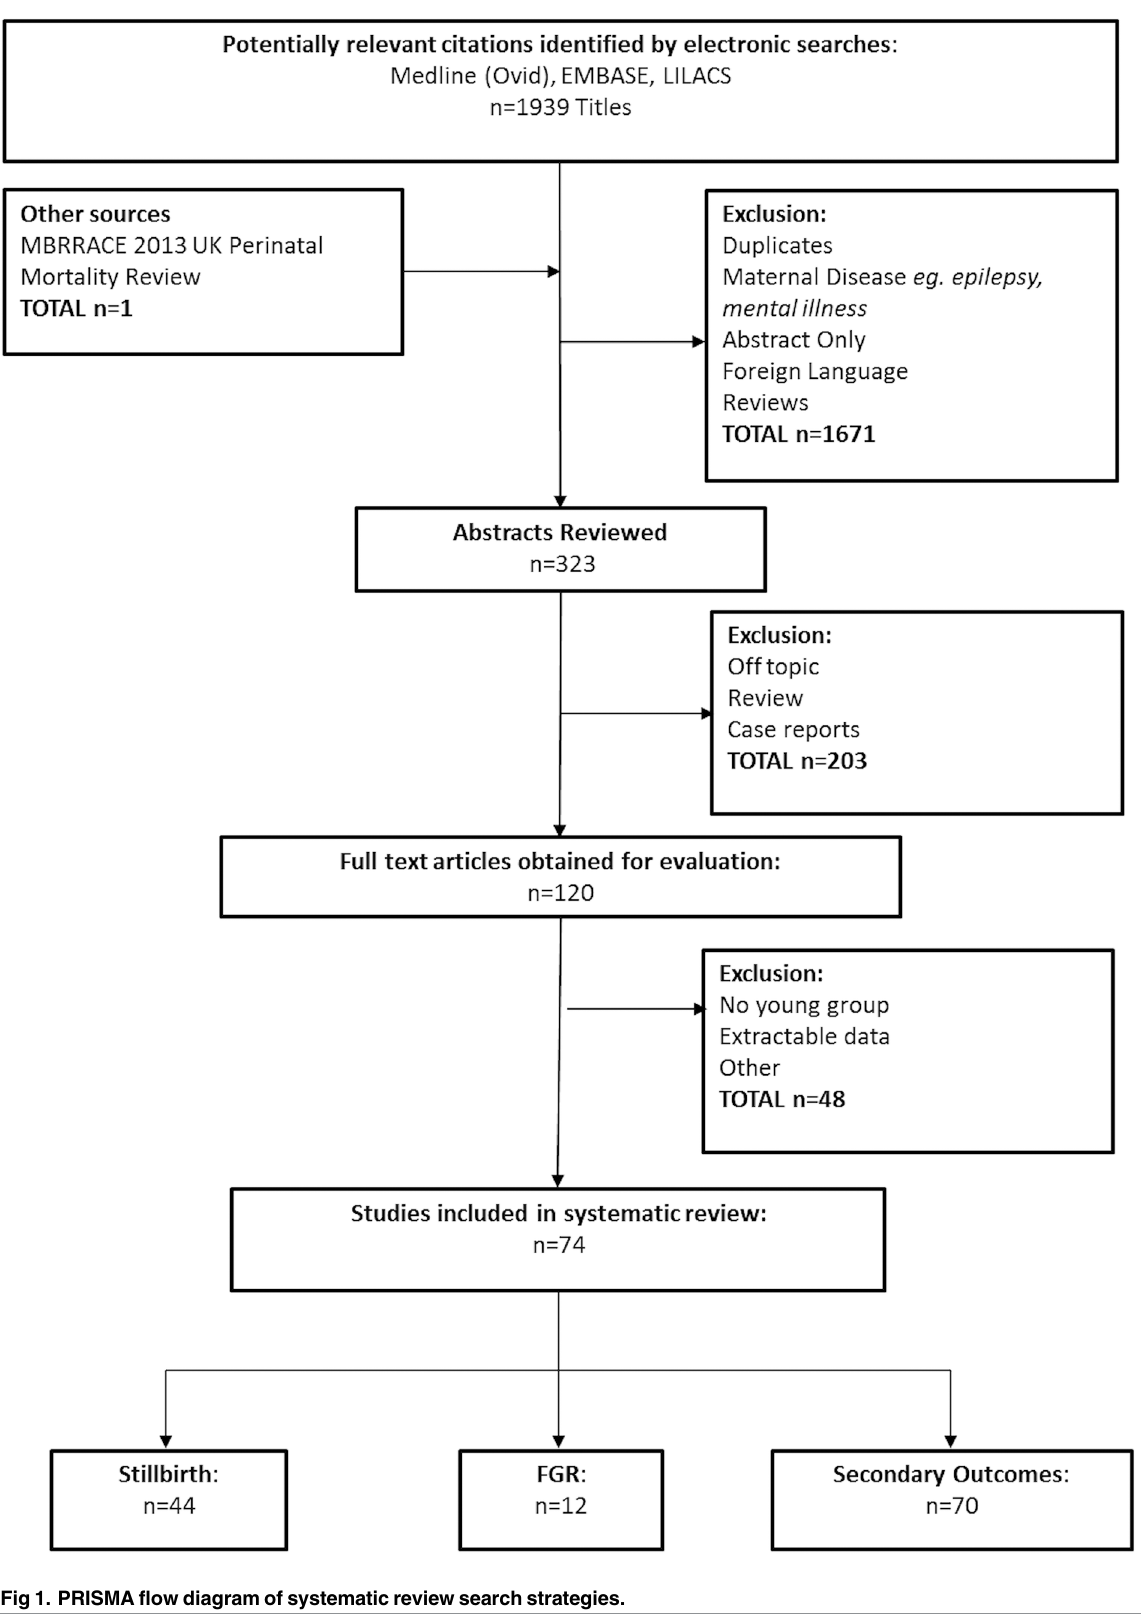
Fig 1. PRISMA flow diagram of systematicreview search